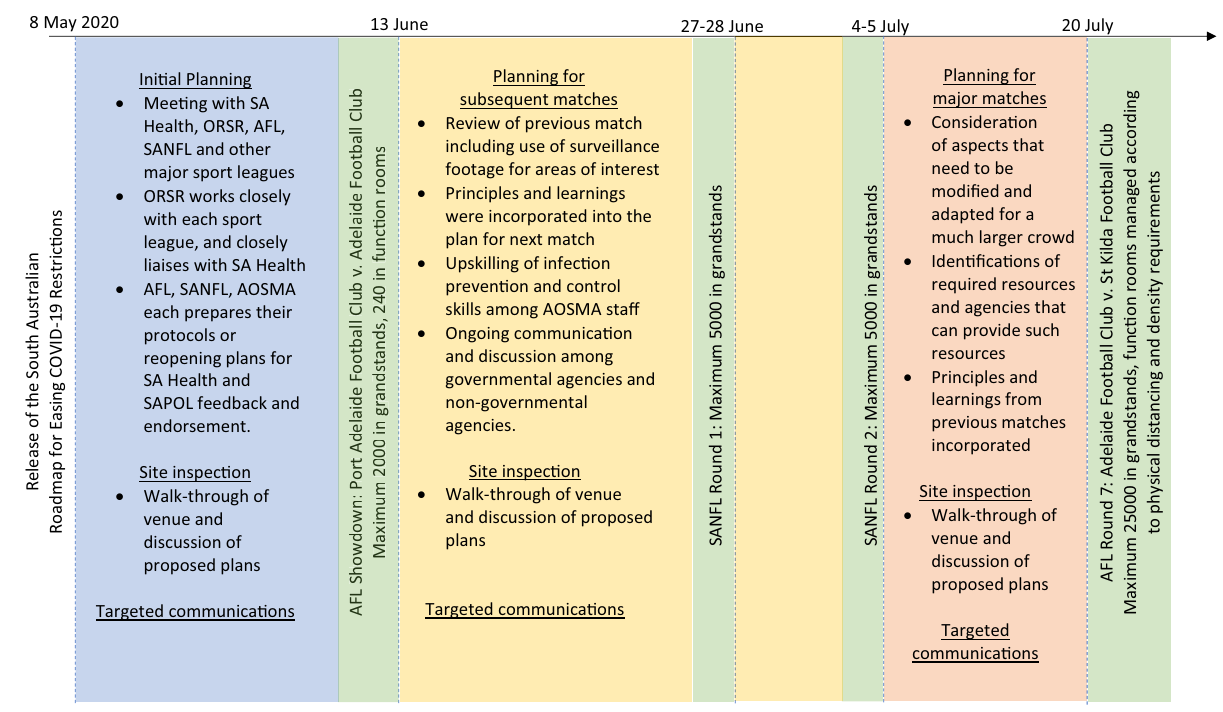
FIGURE 1 | Timeline illustrating the staged and controlled recommencement of sport leagues with spectator attendance at the Adelaide Oval. SA Health, Department for Health and Wellbeing; ORSR, Office for Recreation, Sport and Racing; AFL, Australian Football League; SANFL, South Australian National Football League; AOSMA, Adelaide Oval Stadium Management Authority; SAPOL, South Australian